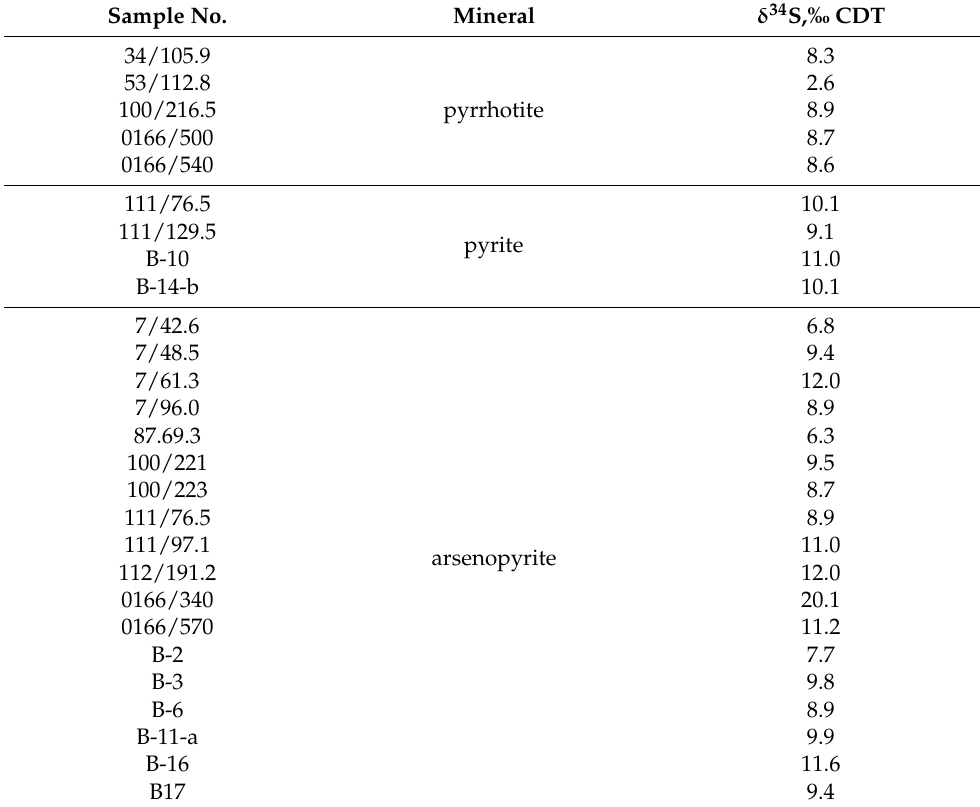
Table 4. Sulfur isotopic composition of sulfides from the Blagodatnoye gold deposit. Sample